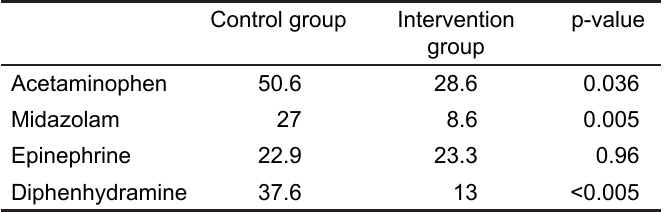
Table 3b. Time-to-medication delivery in each